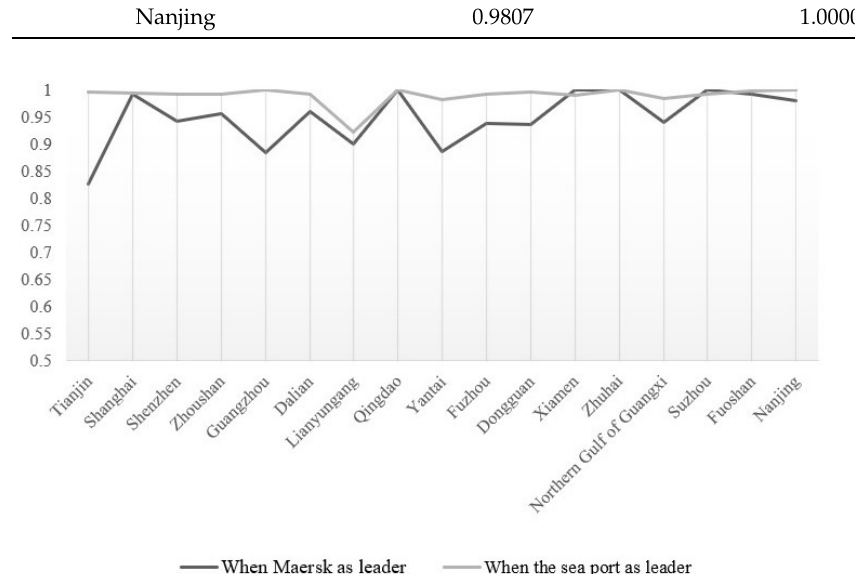
Figure 5. The sustainable efficiency of ports under different